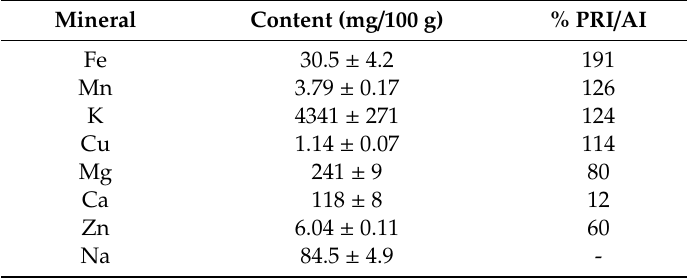
Table 4. Mineral composition of